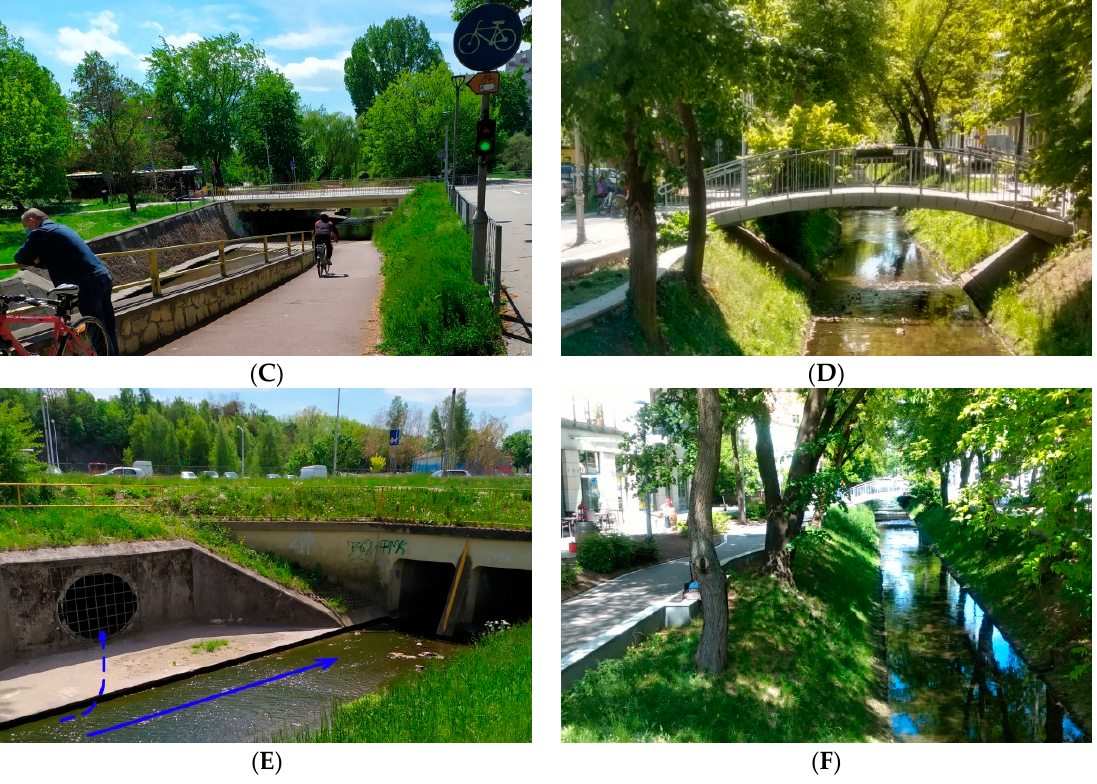
Figure 5. Selected hydrotechnical structures after modernisation or construction: ( A ) weir, ( B ) tunnel/relief channel, ( C ) bridge and bicycle path, ( D ) arch bridge, ( E ) relief channel inlet above the road culvert and ( F ) flood retaining wall.